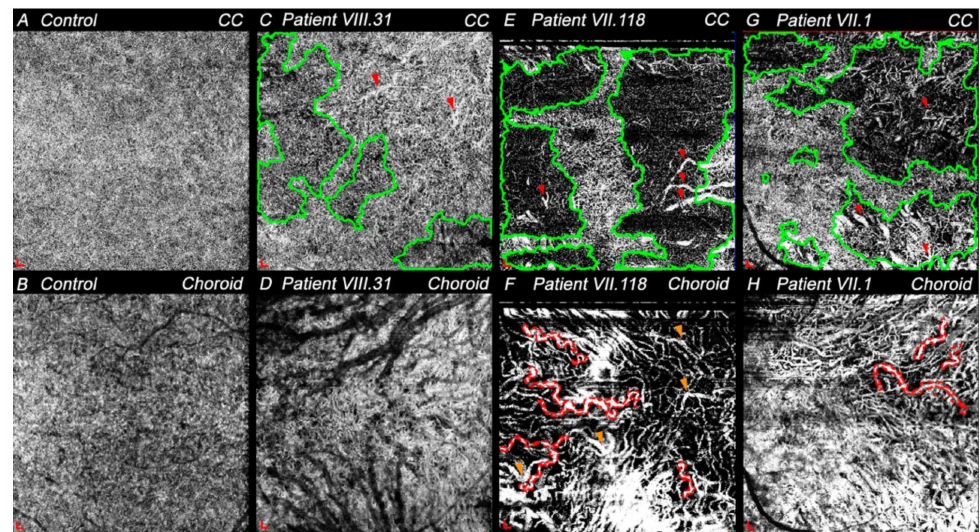
Figure 5. OCTA images of choriocapillaris (CC) and choroid centered at the macula in control and study patients. ( A ) Granular pattern typical of CC of a healthy patient. ( B ) Choroid seen with OCTA in a normal patient. Projection artifact of large retinal vessels can be observed. ( C ) CC from patient VIII.31 (LE) with attenuated areas (green areas) between the fovea and optic nerve. Red arrowheads indicate some inner choroid vessels due to the CC thinning. ( D ) Some inner and outer choroid vessels (dark vessels) can be observed in patient VIII.31 (cid:48) s choroid (LE). ( E ) The granular pattern of the CC is mainly preserved close to the fovea of VII.118 (RE). Green areas show impaired vascular perfusion and red arrowheads point to some choroid vessels. ( F ) Vascular tortuosity (red dotted areas) of larger vessels and focal vascular dilation (orange arrowheads) were seen in patient VII.118 (RE). ( G ) Larger impaired vascular perfusion areas (green areas) are shown in CC of VII.1 (LE). Thus, inner and outer choroid vessels were detected (red arrowheads). ( H ) Vascular tortuosity (red dotted areas) was present in VII.1 (LE) and inner choroid vessels were easily detected. Scale: 200 × 200 µ